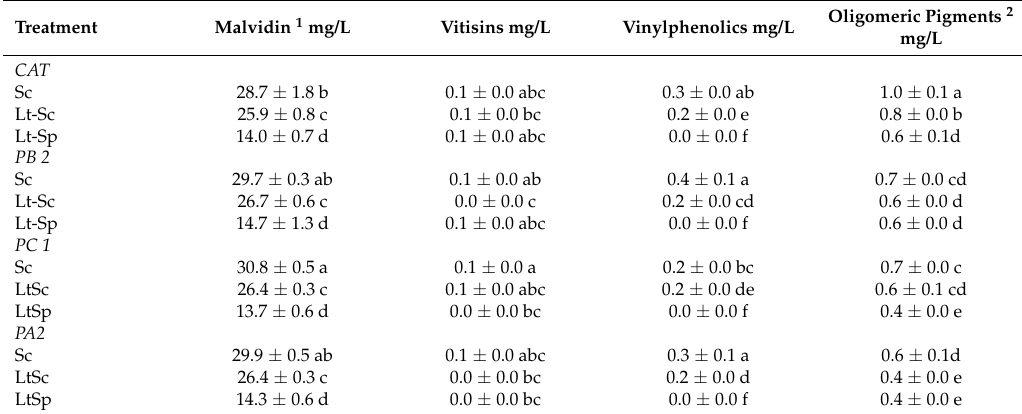
Table 3. Summary of pigments found in experimental red wines. The statistical analysis is given by parameter (columns) and the difference in letters indicates significant statistical difference (LSD method with 95% confidence level). Means ± STD ( n =